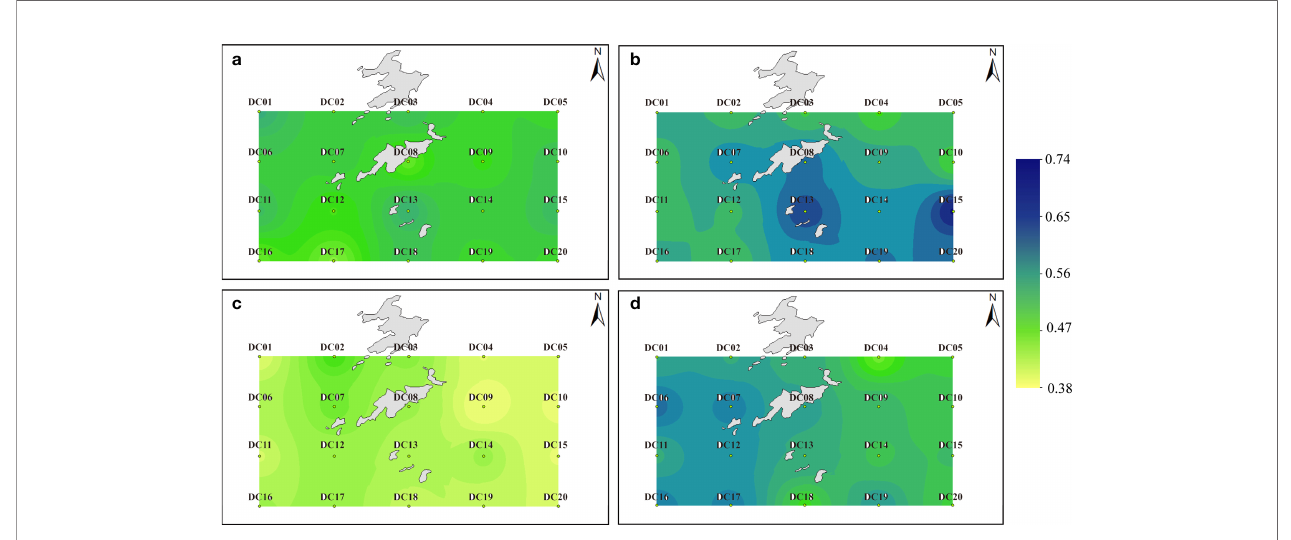
FIGURE 4 | The interannual variation of the MEECC in (A) November 2019, (B) September 2020, (C) January 2021, and (D) April